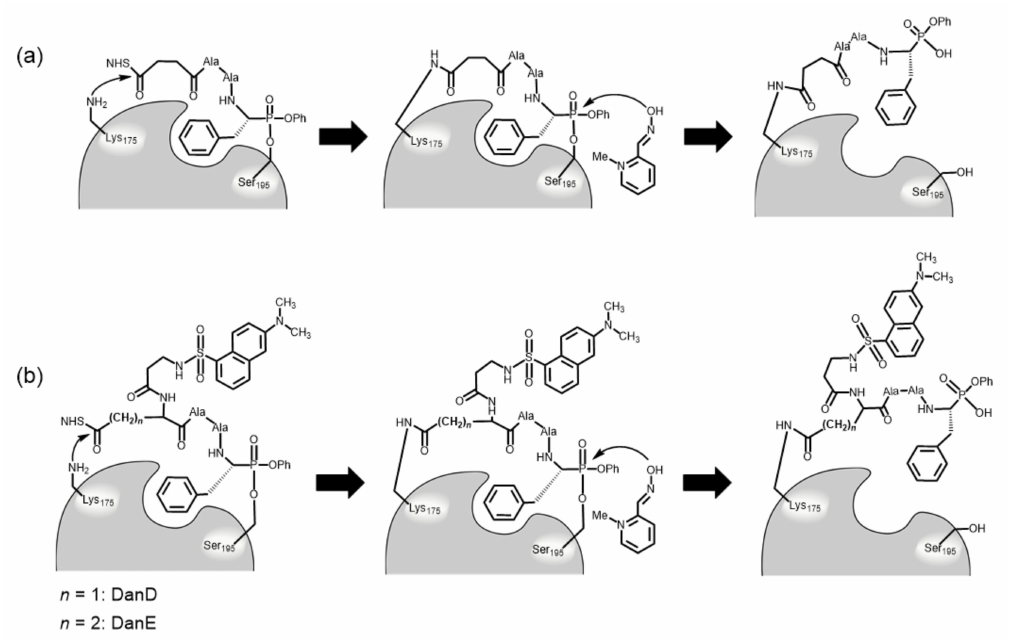
Figure 1. Site-selective chemical modification of Lys175 in Csin with the peptidyl phosphonate derivatives NHS-Suc-Ala-Ala-( R )-Phe P (OPh) 2 ( a ), DanD and DanE ( b